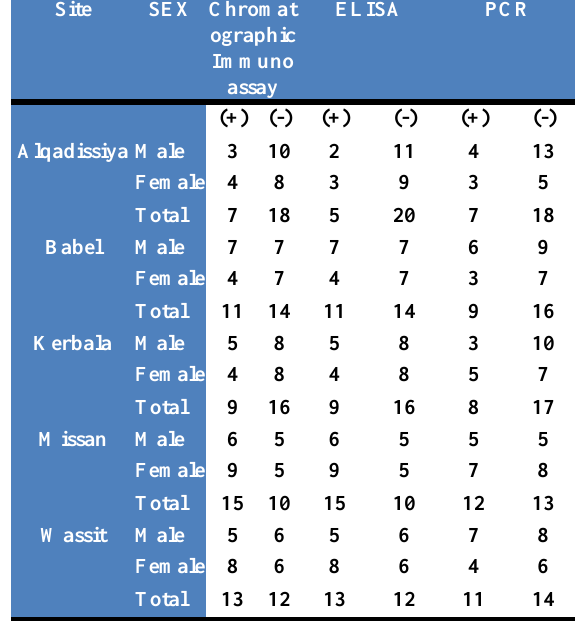
Table, 2: Comparison of results between three testing methods for Rotavirus in 125 fecal samples.